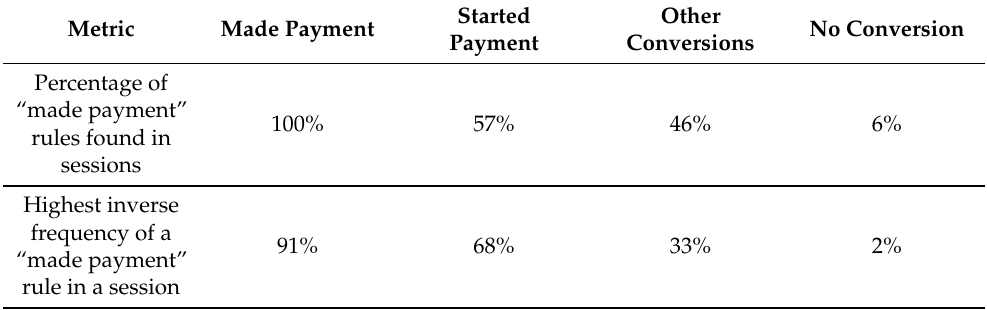
Table 3. Rules selected for each class of visitors: the nested rules with inverse frequency ≥ 5%. Metric Made Payment Percentage of “made payment” rules found in Highest inverse frequency of a “made payment”